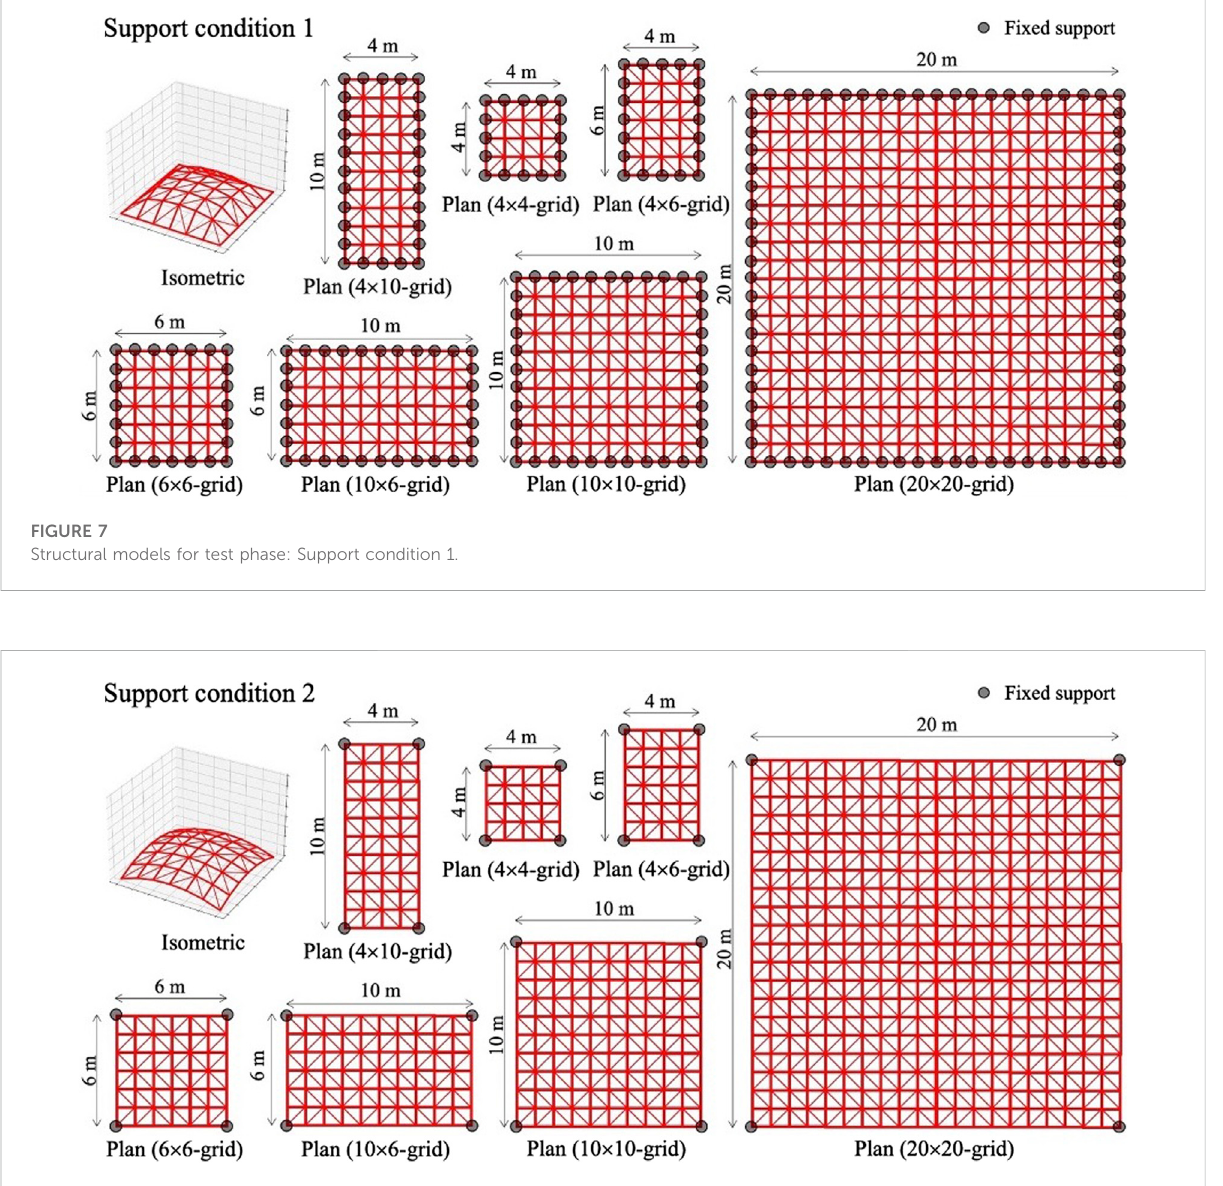
FIGURE 8 Structural models for test phase: Support condition